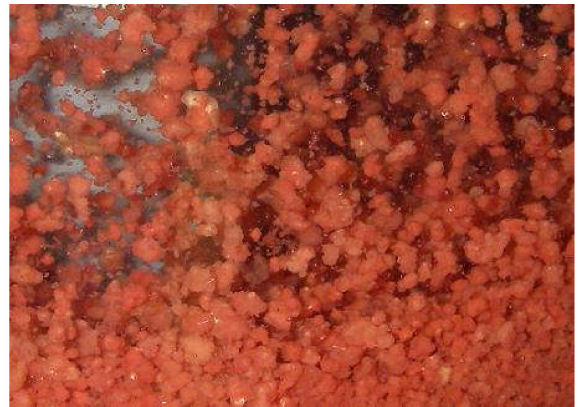
Figure 2. ANAMMOX granular sludge sample.